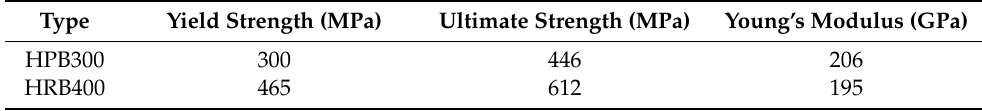
Table 3. The main mechanical properties of the steel